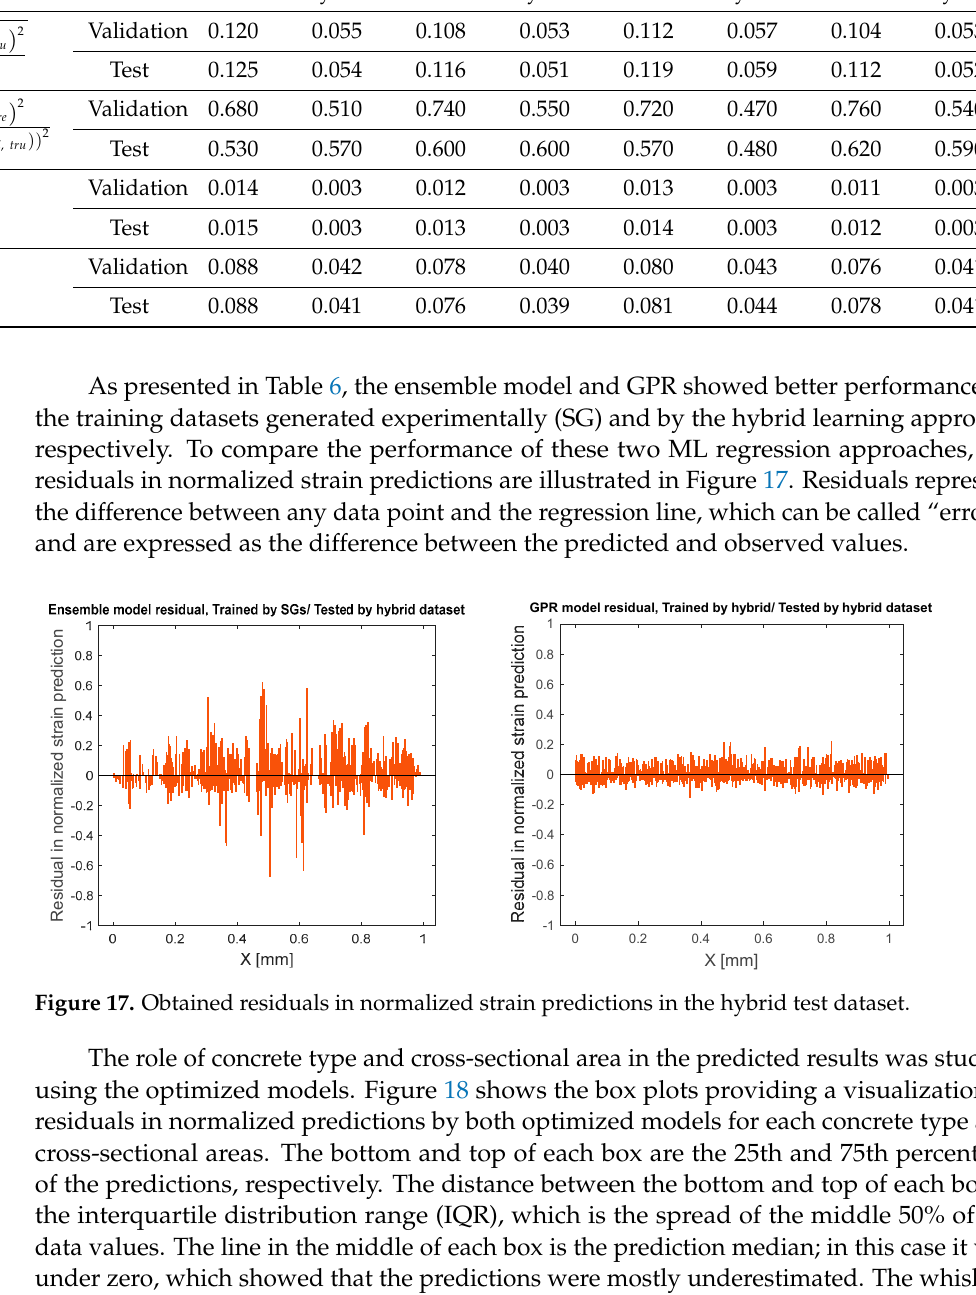
Figure 18. Box plot visualization of summary statistics for residuals in normalized predictions for each concrete type and cross-sectional area. Overall, the GPR model trained with a hybrid learning approach showed the best performance among all the studied models. Figure 19 shows the predicted strain by the GPR model using a hybrid learning approach on embedded reinforcement for 2N100 under di ff erent loading levels. As a reminder, the obtained datasetfrom this specimen was not observed in the training phase and the predicted strain presented alongside the data collected from the installed SGs was used to verify the performance of the proposed method. There was obviously some outlier noise in the predicted values, which could be eliminated to improve the results by post-processing the predictions.